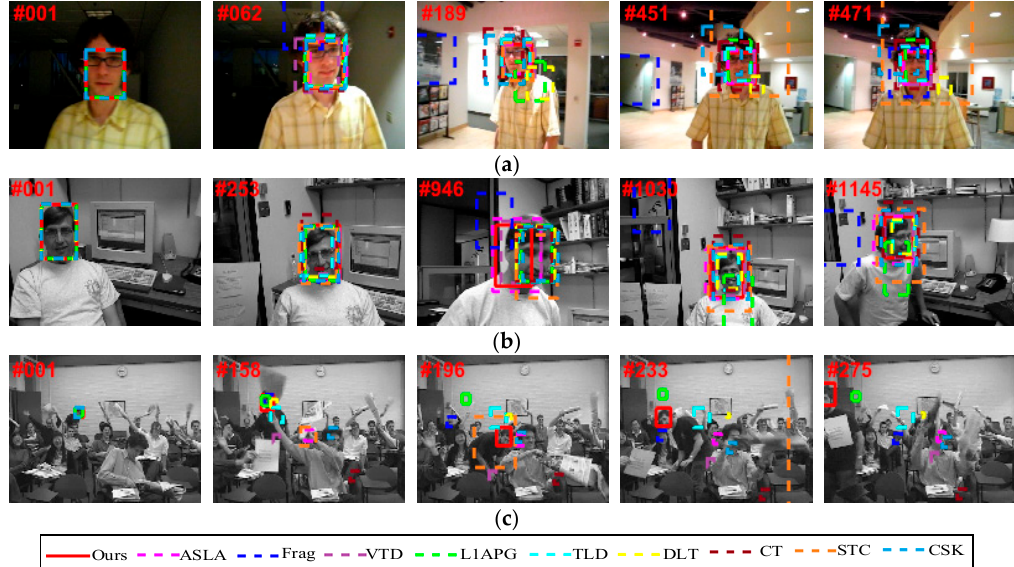
Figure 11. Screenshots of some sampled tracking results, where objects suffer from rotation. ( a ) David with rotation and illumination variation; ( b ) Dudek with rotation and scale variation; ( c ) Freeman4 with rotation and occlusion.